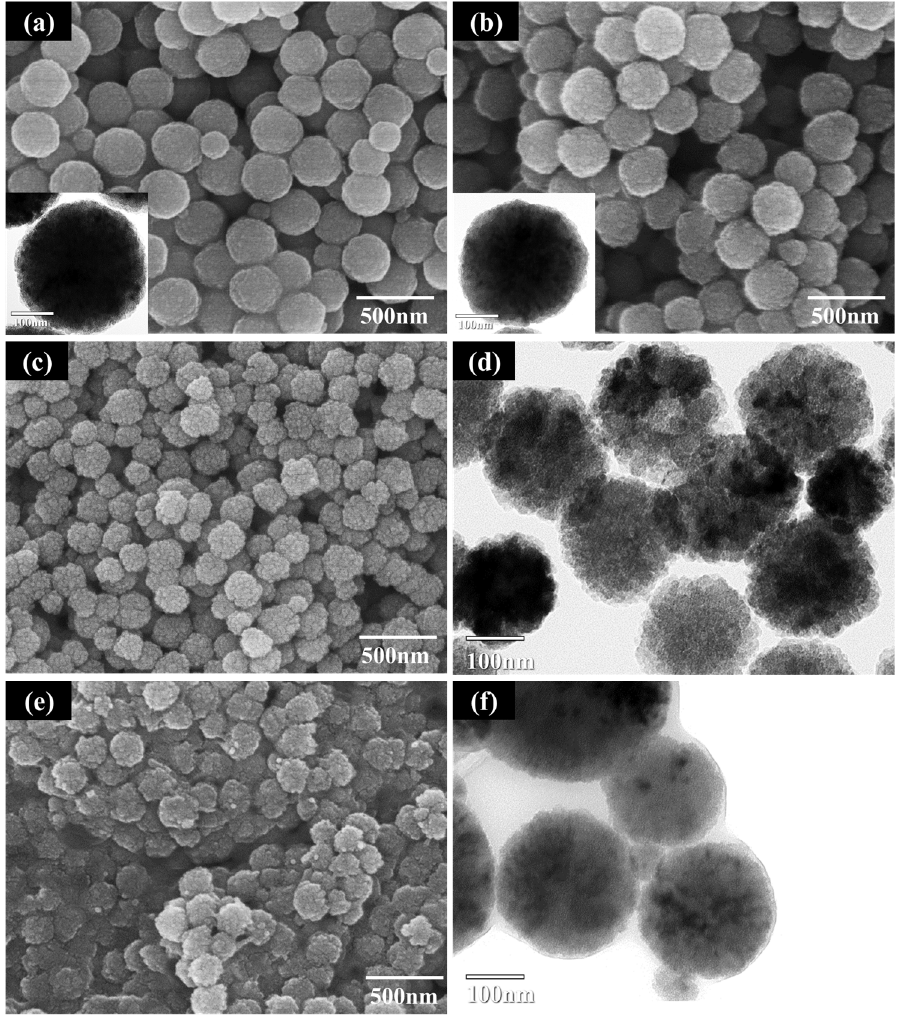
Figure 3. FE ‐ SEM and TEM images of Fe 3 O 4 before and after surface modification: ( a ) as ‐ prepared Figure 3. FE-SEM and TEM images of Fe 3 O 4 before and after surface modification: ( a ) as-prepared Fe 3 O 4 ; ( b ) Fe 3 O 4 modified using 1 wt % PAA; ( c ) 5 wt % PAA (FE ‐ SEM image); ( d ) 5 wt % PAA (TEM Fe 3 O 4 ; ( b ) Fe 3 O 4 modified using 1 wt % PAA; ( c ) 5 wt % PAA (FE-SEM image); ( d ) 5 wt % PAA (TEM image); (e) 10 wt % PAA (FE ‐ SEM image); (f) 10 wt % PAA (TEM image). image); ( e ) 10 wt % PAA (FE-SEM image); ( f ) 10 wt % PAA (TEM The high resolution XPS spectra were measured for Fe 2p, C 1s, and O 1s of as ‐ pre ‐ pared Fe 3 O 4 and Fe 3 O 4 modified using various PAA contents (Figure 4). The spectra of Fe 2p exhibited two peaks at 710.1 and 723.5 eV corresponded to Fe 2p 3/2 and Fe 2p 1/2, respectively [28]. The spectra were deconvoluted into four component peaks located at 709.8 and 723.3 eV (Fe 3+ –O), 712.8 and 729.5 eV (Fe 2+ –O). According to previous studies, it has been reported that the satellite peak at 719.0 eV related to Fe 3+ in γ‐ Fe 2 O 3 is not ob ‐ served in the Fe 2p spectra of Fe 3 O 4 [29 ‐ 32]. All the Fe 2p spectra obtained in this study do not have the satellite peak at 719.0 eV even after surface modification using PAA (Figure 4a). For this reason, it is deduced that the addition of PAA does not influence to oxidation of Fe 3 O 4 to γ‐ Fe 2 O 3 . After the surface modification using PAA, changes on the spectra were observed in the XPS results of Fe 2p, C 1s, and O 1s. Intensity of the peaks for the Fe 2p 3/2 and Fe 2p 1/2 decreased as the PAA content increased. In the spectra of C 1s, intensity of the peaks at 284.8 and 288.4 eV increased as the increase in PAA content. The peaks are related to C–C/C–H and O–C=O, respectively [33,34]. In the Figure 4c, the spectra of O 1s are con ‐ sisted of three component peaks located at 531.1, 532.0, and 532.5 eV corresponded to Fe– O–Fe, Fe–O–H, and O–C=O, respectively [31]. As the PAA content increased, the spectra of O 1s exhibited the similar tendency with the spectra of Fe 2p and C 1s. Intensity of Fe–